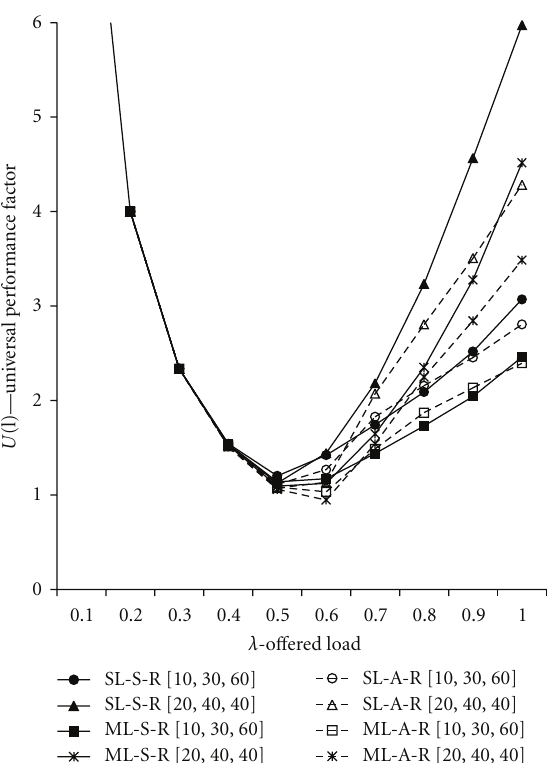
Figure 10: Universal performance factor of medium-priority packets versus o ff ered load.